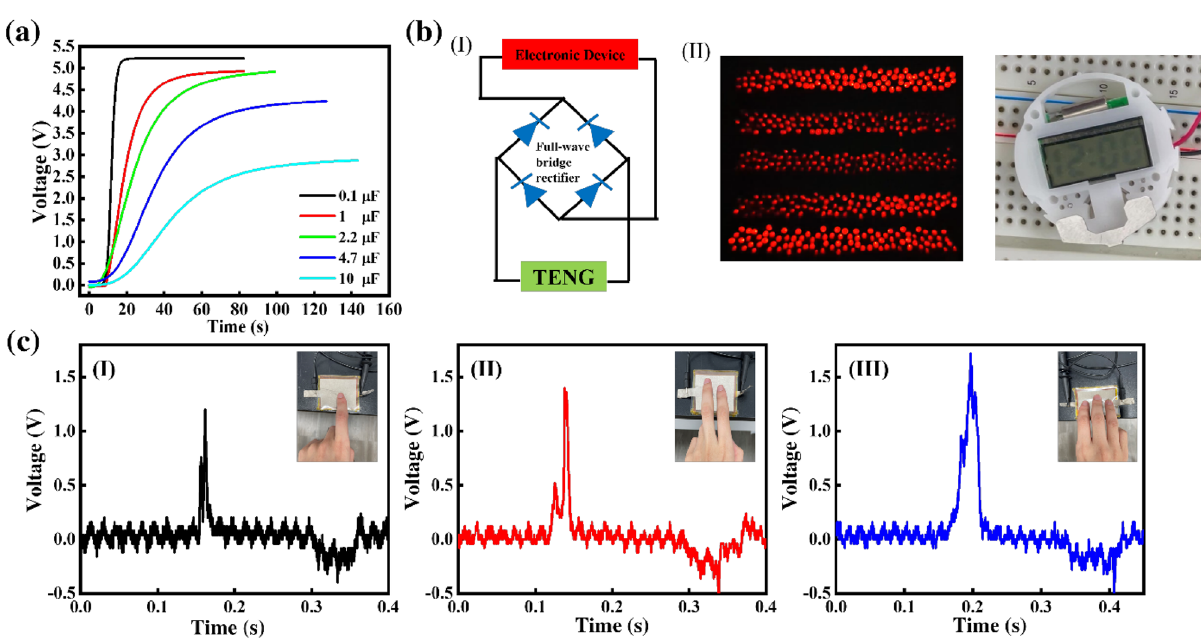
Figure 4. ( a ) Capacitor charging of P3HT/PVDF-HFP nanofibers TENGs having various capacitances. ( b ) (I) Schematic representation of the operating circuit for LED bulbs with a full-wave bridge rectifier and (II) photograph of 500 serially connected LEDs and a digital watch powered by a TENG formed from P3HT/PVDF- HFP nanofiber mats (device size: 2.5 cm × 2.5 cm). ( c ) Sensitivity of the P3HT/PVDF-HFP nanofiber TENG, measured by varying the number of fingers pressing on the